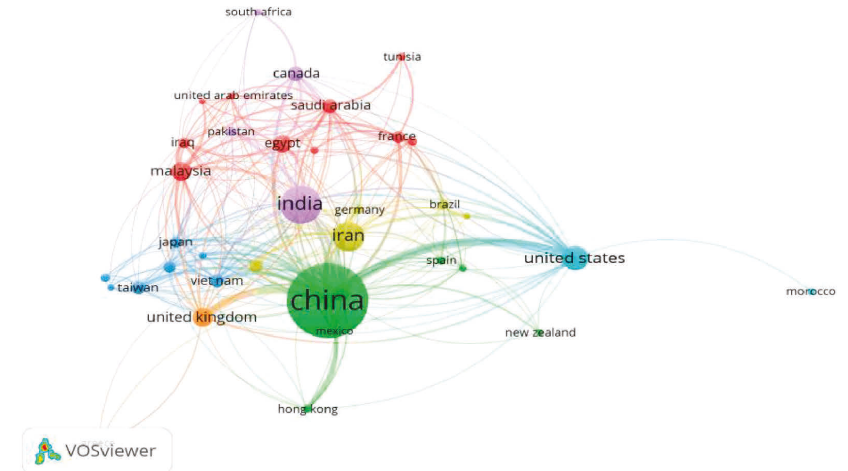
Figure 10: Network visualisation map for country-based co-authorships on PSOA